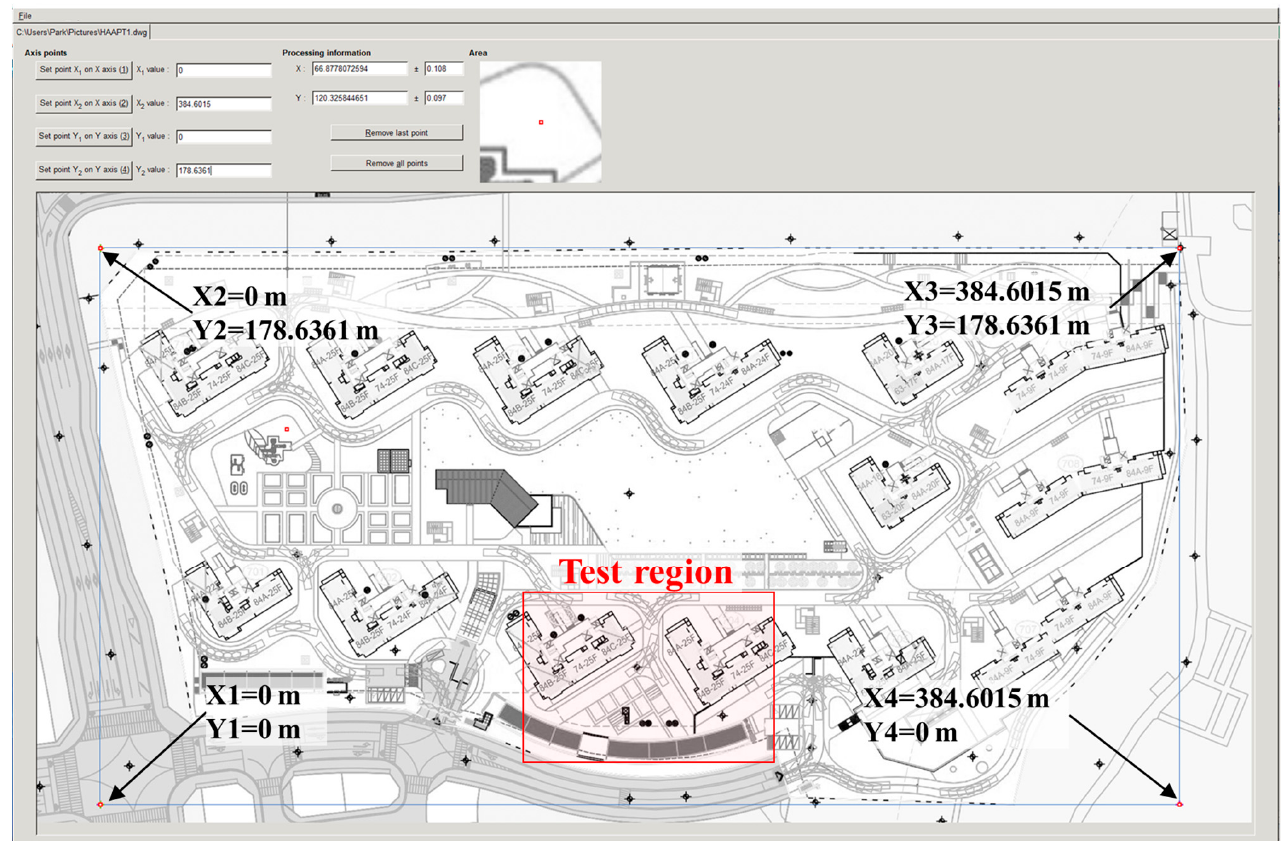
Figure 8. Inputting of XY coordinates of reference drawing.